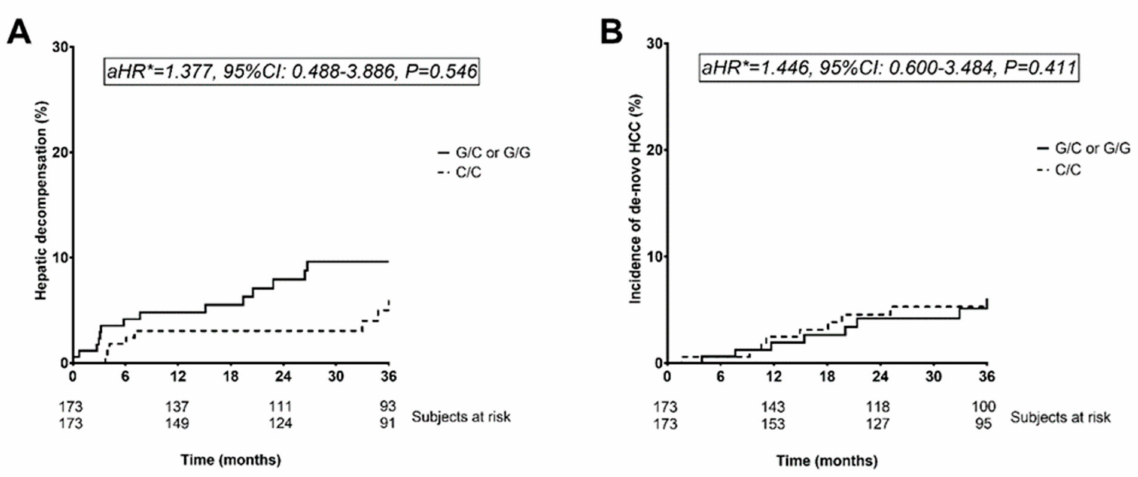
Figure 2. Kaplan–Meier analyses of ( A ) hepatic decompensation and ( B ) the incidence of de-novo HCC in the overall cohort (cohort B), comparing carriers and non-carriers of PNPLA3 rs738409 G-allele. * Adjusted hazard ratio (aHR) was calculated using Cox regression analysis adjusting for history of hepatic decompensation, baseline MELD score, and baseline albumin level. Abbreviations: aHR adjusted hazard ratio, HCC hepatocellular carcinoma, HR hazard ratio, PNPLA3 patatin-like phospholipase domain-containing